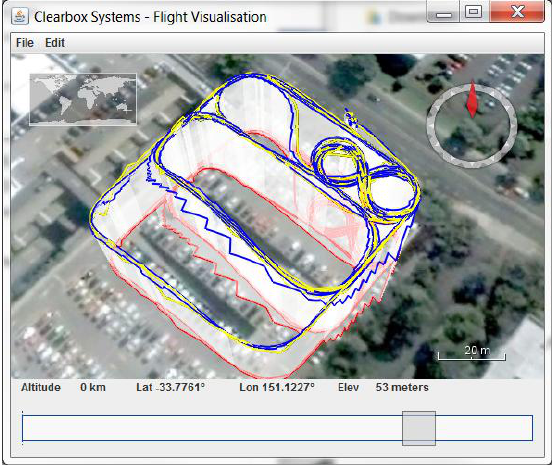
Figure 4 - Compensated GNSS